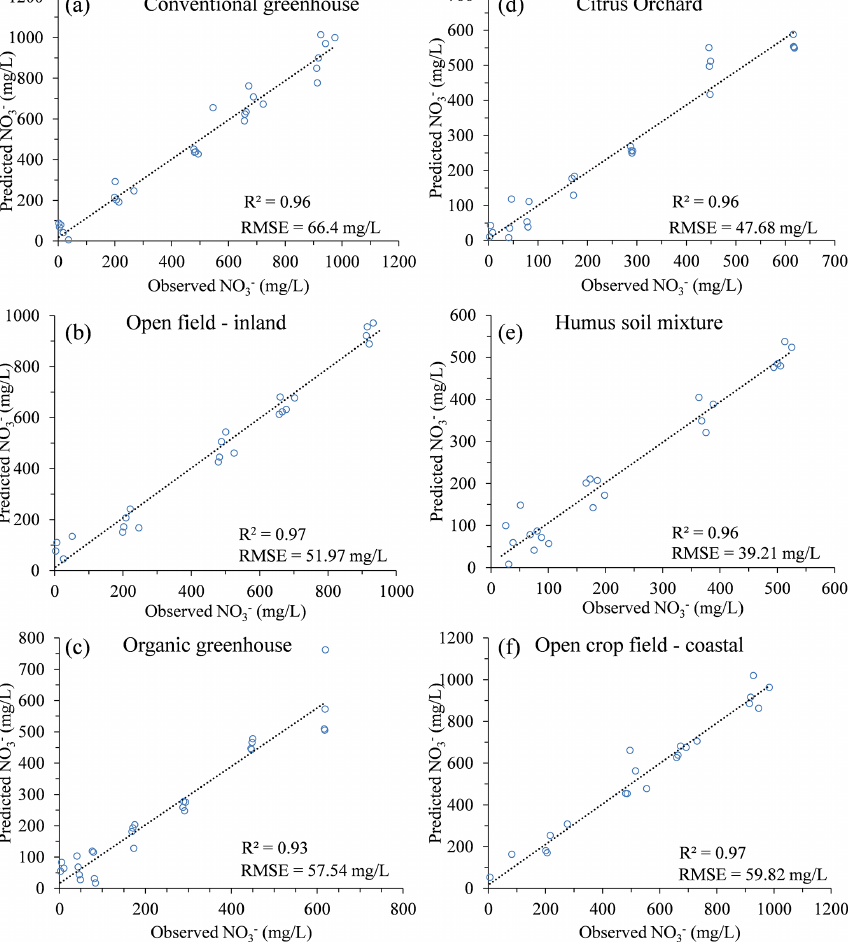
Figure 3. Observed vs. predicted nitrate concentrations. Table 4. Nitrate predication statistics and DOC/nitrate concentration range for the examined soil